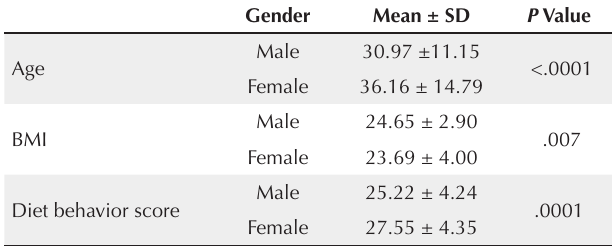
Table 3. Comparison of Age, BMI and Diet Behavior Score by Gender